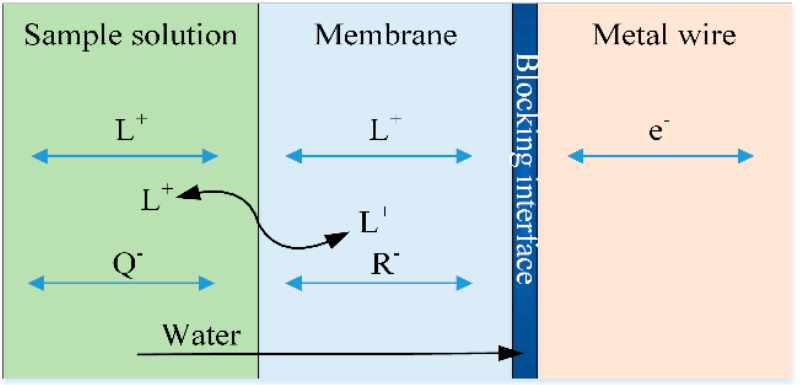
Figure 1. Charge transportation and blocking interface in coated wire electrodes (CWE). L + : cation to be measured; Q − : anion in sample solution, R − : anion in membrane; e − : electron.